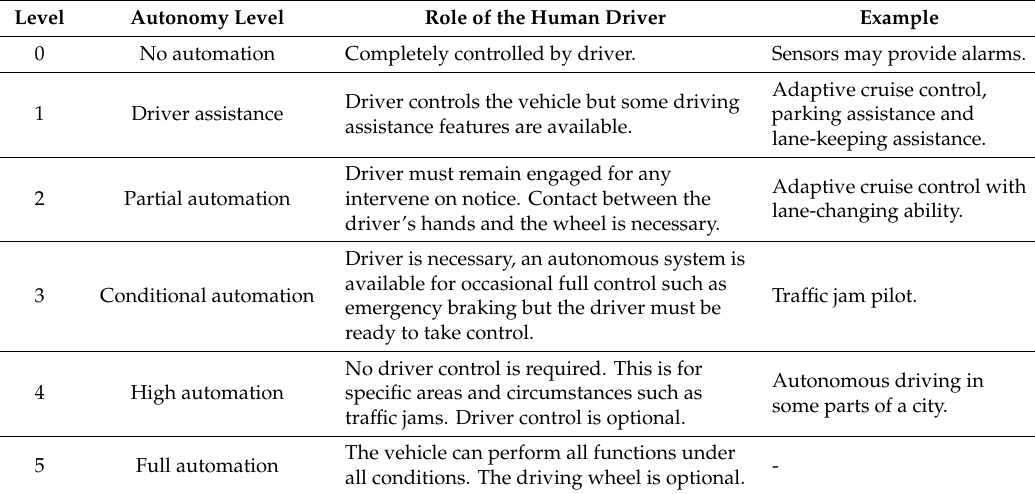
Table 2. The five stages of autonomy in smart